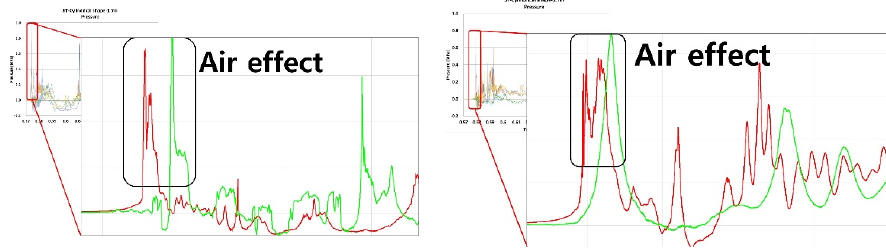
Figure 20. Air effect at a bottom thickness of 5 and 8 mm in cylindrical shape model. Figure 20. Air e ff ect at a bottom thickness of 5 and 8 mm in cylindrical shape